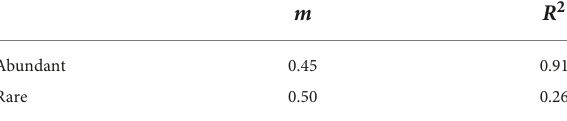
TABLE 1 Fit of the neutral model in abundant and rare fungal sub-communities in desert soil.